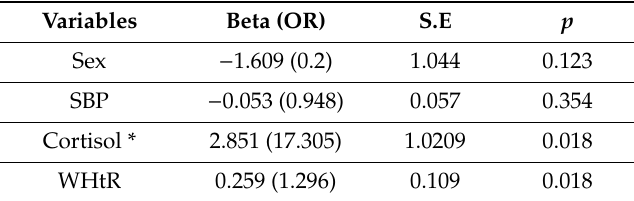
Table 5. Logistic regression analysis to predict LVH ( n =